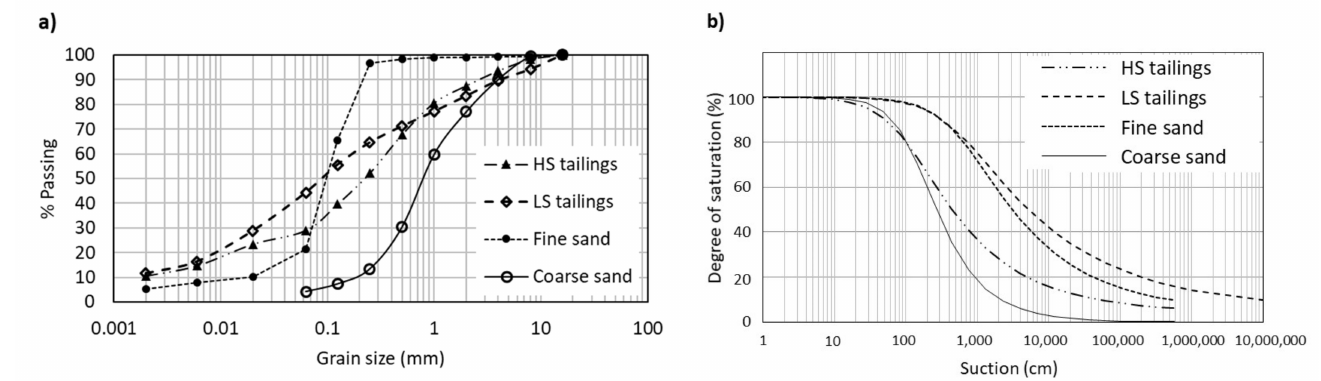
Figure 3. ( a ) particle size distribution of the materials used to build the column experiments. ( b ) water retention curves of the materials used to build the column